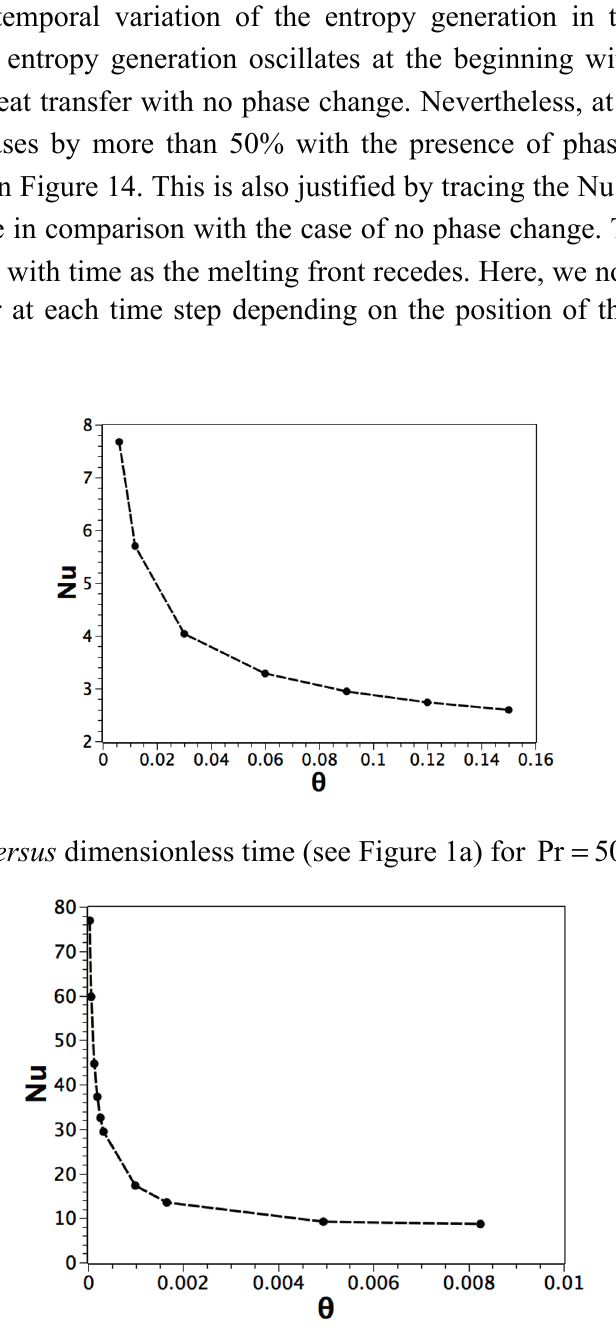
Figure 12. Nu versus dimensionless time (see Figure 1a) for Pr 50 = and 5 Ra 10 =